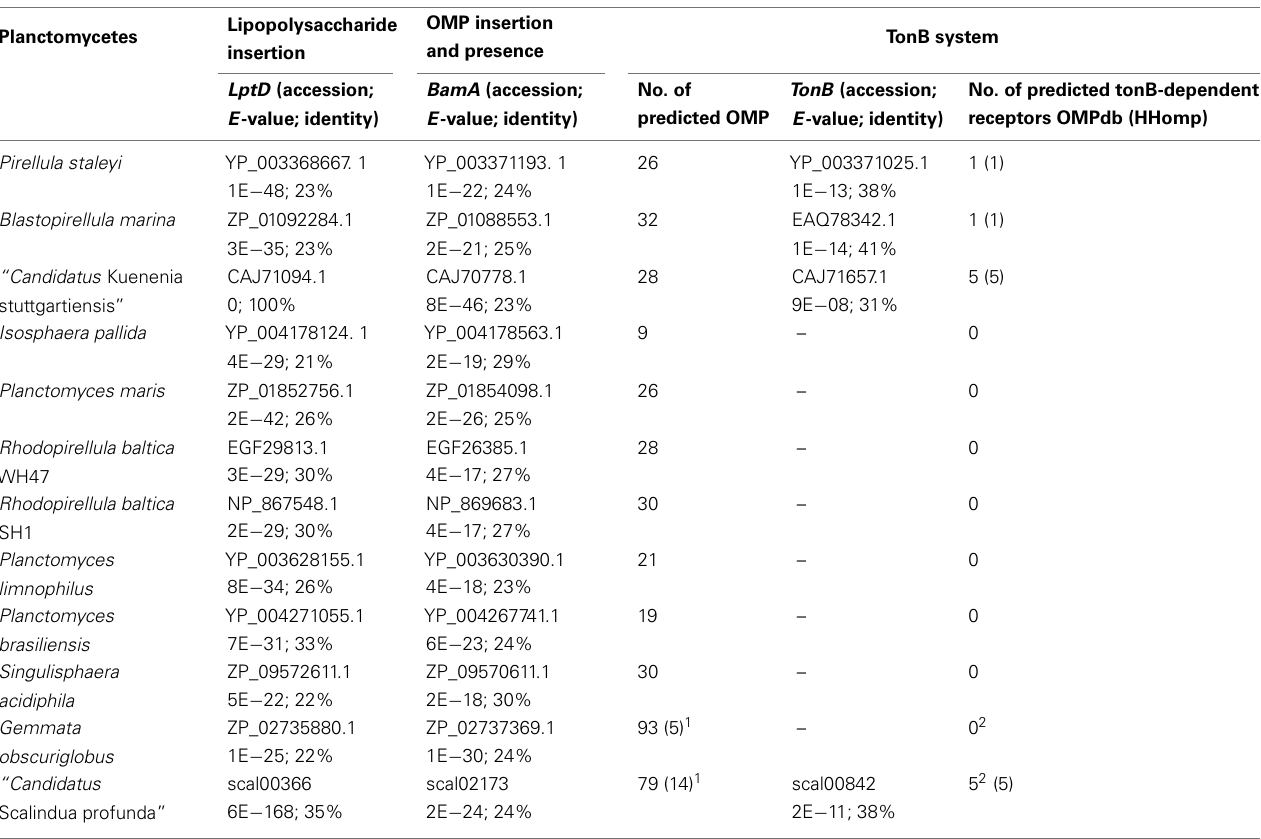
Table 1 | Presence of outer membrane biomarkers in genomes of